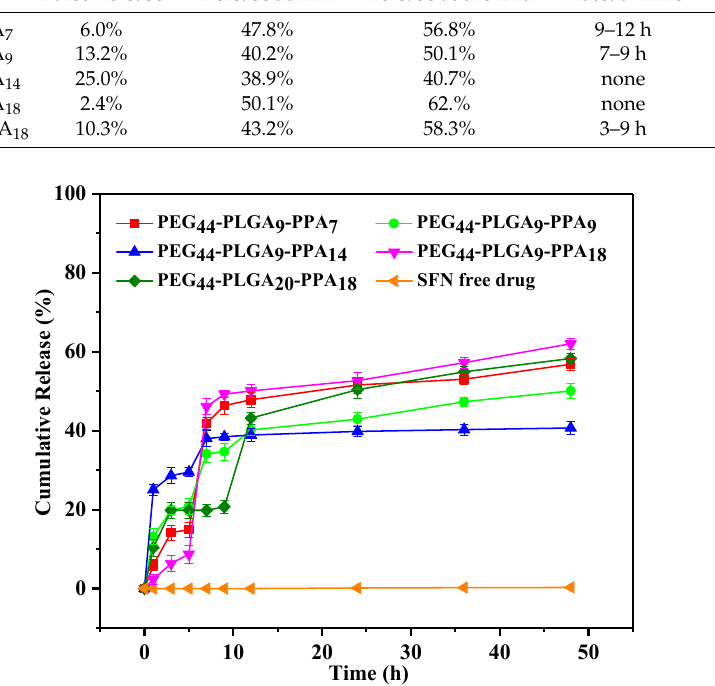
Figure 8. Cell viabilities of HeLa cells incubated with polymer micelles for 24 h (n = 3, mean ± SD).